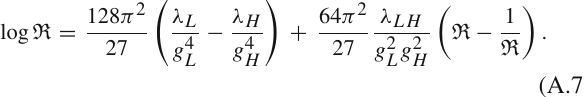
hierarchy is not very large in order to properly visualise the variations in the plot. We have an initial hierarchy R > 1 with the minimum ( (cid:14) ) in a position (cid:6) η (cid:7) > (cid:6) ϕ (cid:7) . If we include a λ LH (cid:4)= 0 coupling this situation changes, but the effect of this parameter is quite different depending on its